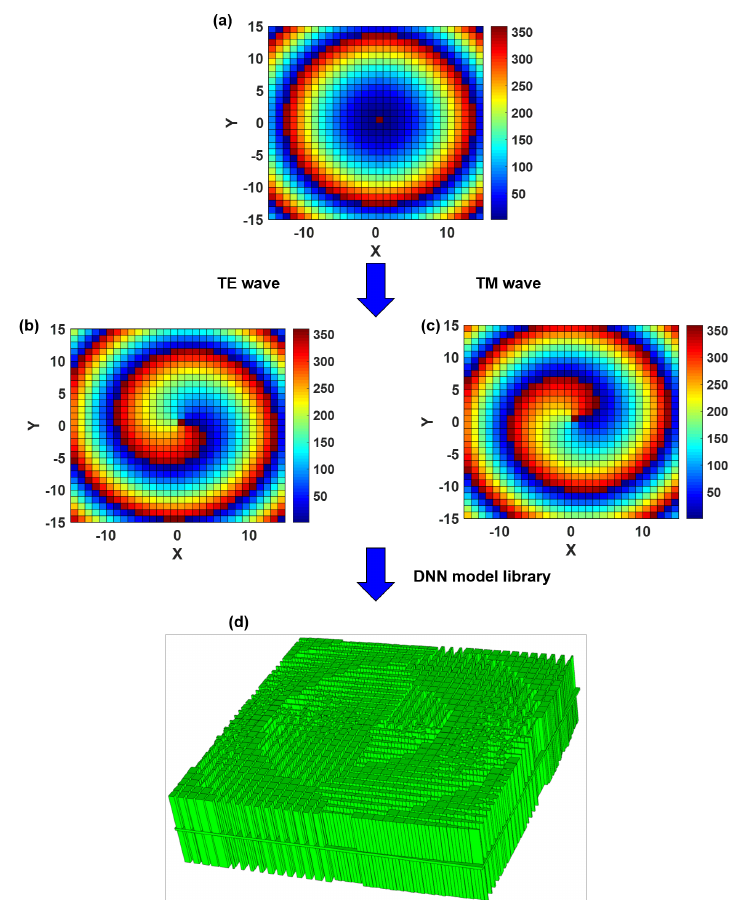
Figure 4. The calculation compensation phase distribution and process on the dielectric lens. (a) Phase compensated for feed spherical. (b) Compensation phase distribution required to generate l = 1 mode vortex wave after TE wave irradiation. (c) Compensation phase distribution required to generate l = 1 mode vortex wave after TE wave irradiation. (d) Dielectric lens structures generated by machine learning.